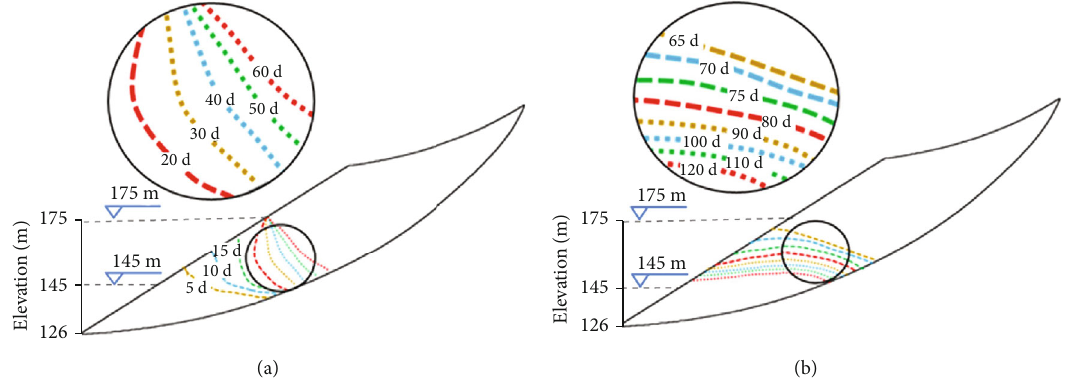
Figure 8: Distributions of phreatic line: (a) in the reservoir water level rising and constant high reservoir water level period; (b) in the reservoir water level falling and constant low reservoir water level